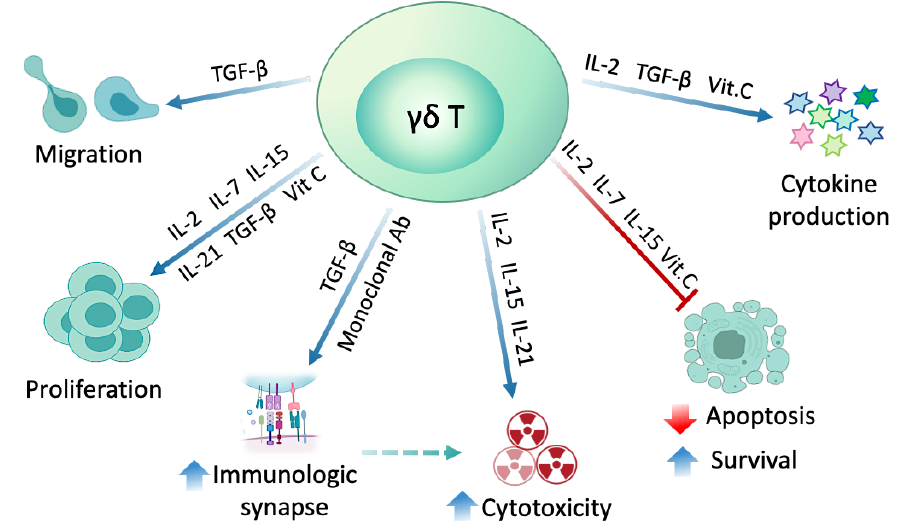
Figure 3. γδ T cells modulation using different substances. Multiple cytokines such as IL-2, IL-7, IL-15, IL-21 and vitamin C skew the profile of γδ T cells toward Th1-like profile meaning increased proliferation, survival, and cytotoxicity. Transforming growth factor- β (TGF- β ) enhances Th1-like profile, as well as inducing γδ T cells migration and synapse formation with target cells. Monoclonal antibodies (mAb) and bispecific Abs targeting a tumor associated antigen when used in combination with γδ T cell therapy, can direct γδ T cells to the tumor cells and enhance the formation of cell–cell immunological synapse leading to increased cytotoxicity. Ab, antibody; Vit. C, vitamin C.